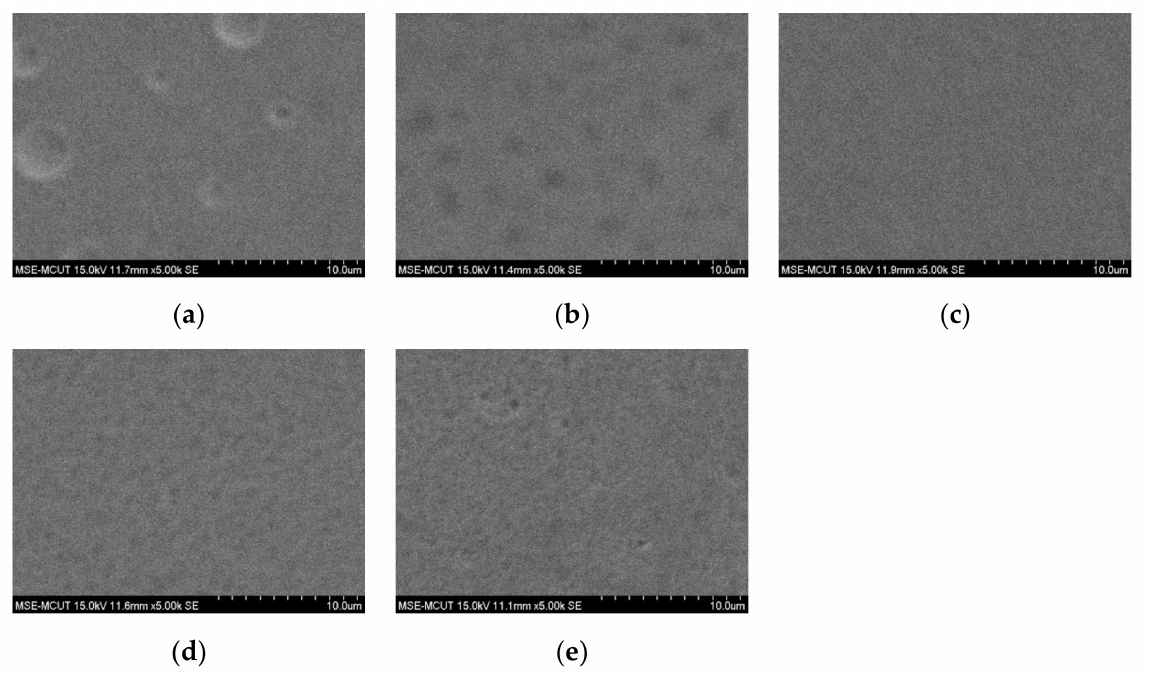
Figure 8. Surface morphologies of silver films obtained with ( a ) one, ( b ) two, ( c ) three, ( d ) four, and ( e ) five passes.